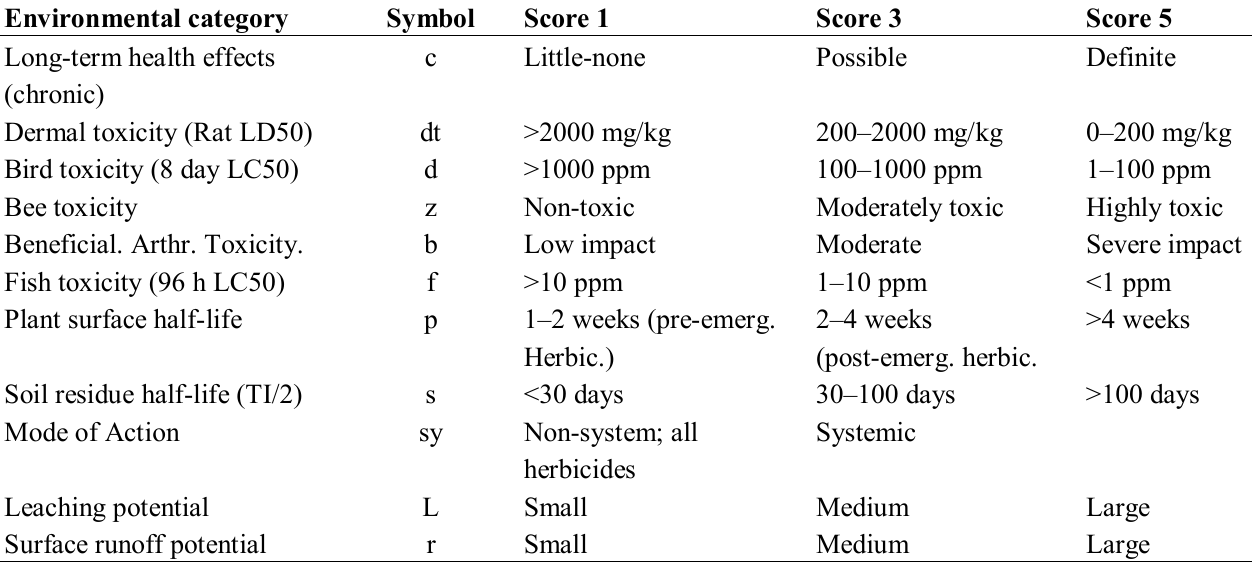
Table 3. Definition for symbols and ratings for each toxicity category in Equation (1).